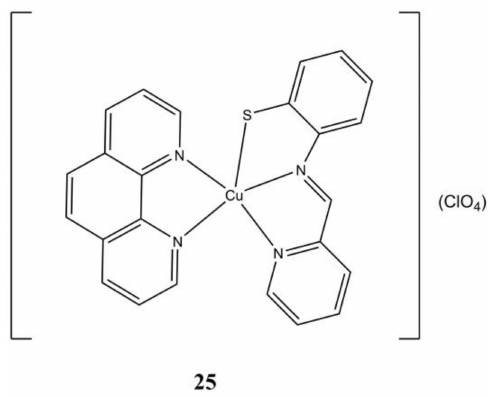
Figure 25. Structure of the [Cu(pabt)(phen)](ClO 4 ) complex. IC 50 values for the compounds here reported are shown in Table 5. Table 5. IC 50 values of compounds Cas-II Gly–25 .